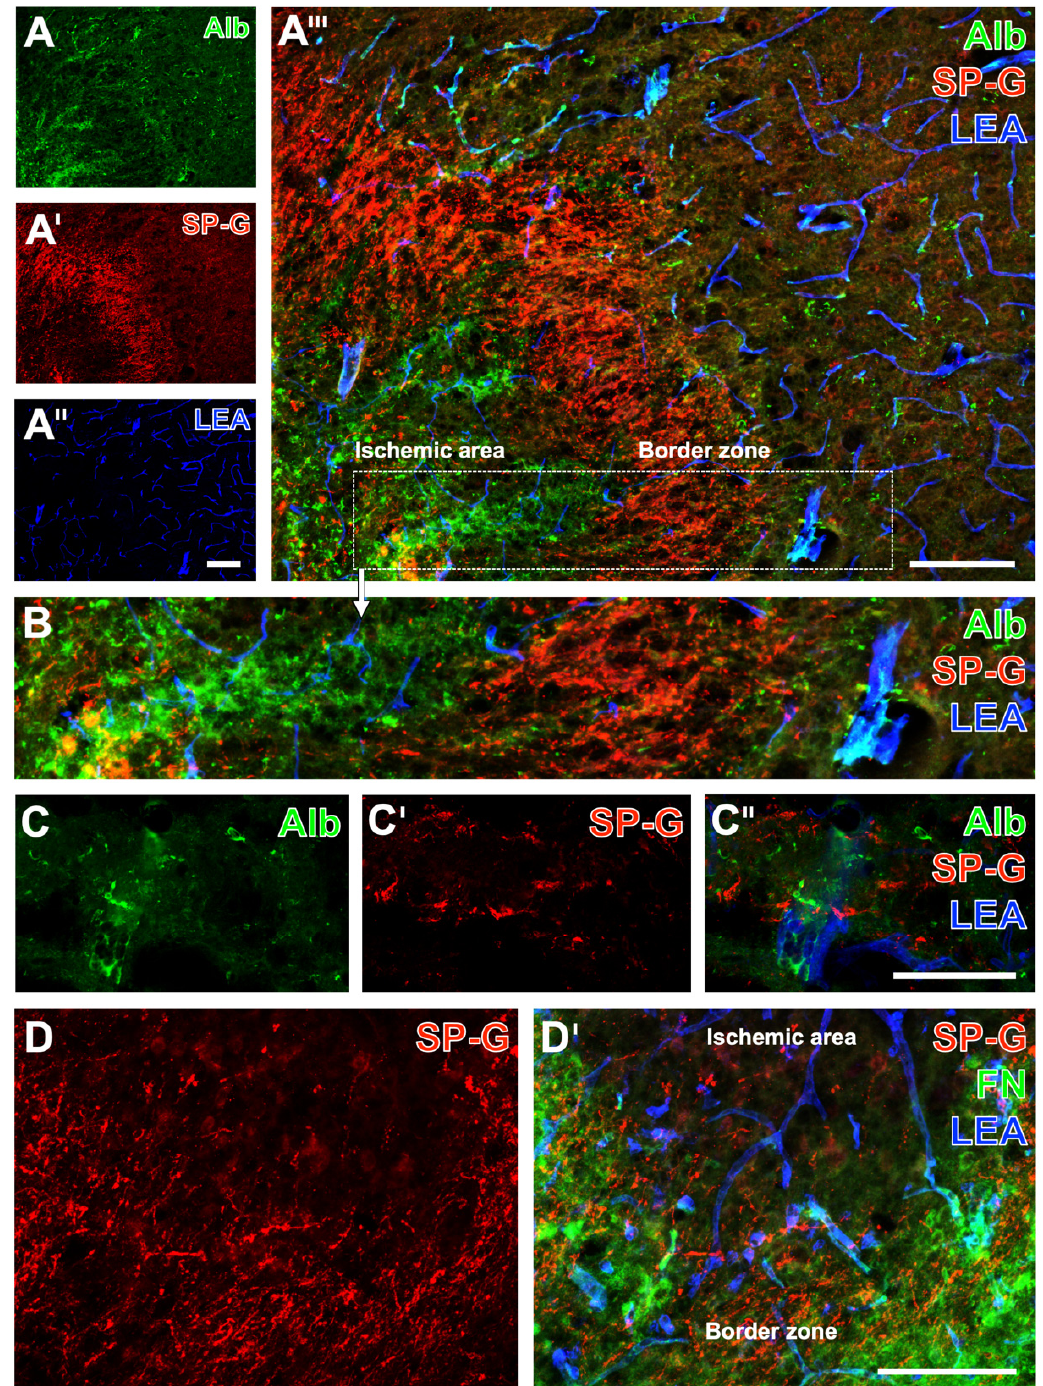
Figure 1. Surfactant protein-G (SP-G) and vascular endothelia in striatal ischemic areas of mice with impaired vasculature’s integrity indicated by extravasation of endogenous albumin into the parenchyma. Representative triple fluorescence labeling of albumin (Alb), SP-G (red), and lectin-based visualization of the vasculature (LEA) in mice 72 h after focal cerebral ischemia ( A – A”’ ), added by a higher magnification of the same labeling at the ischemic border zone ( B ). Exemplary combined detection of Alb, SP-G, and the vasculature (LEA) at a higher magnification captured by laser-scanning microscopy ( C – C’’ ). Triple fluorescence labeling of SP-G, fibronectin (FN), and the vasculature (LEA) after 72 h of focal cerebral ischemia ( D , D’ ). Scale bars: A’’ (also valid for A and A’ ) = 100 μ m, A’’’ = 100 μ m, C’’ (also valid for C and C’ ) = 50 μ m, D’ (also valid for D ) = 100 μ m.